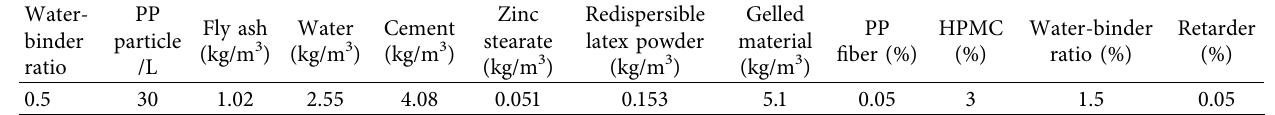
Table 2: Mixture ratio of polystyrene granule